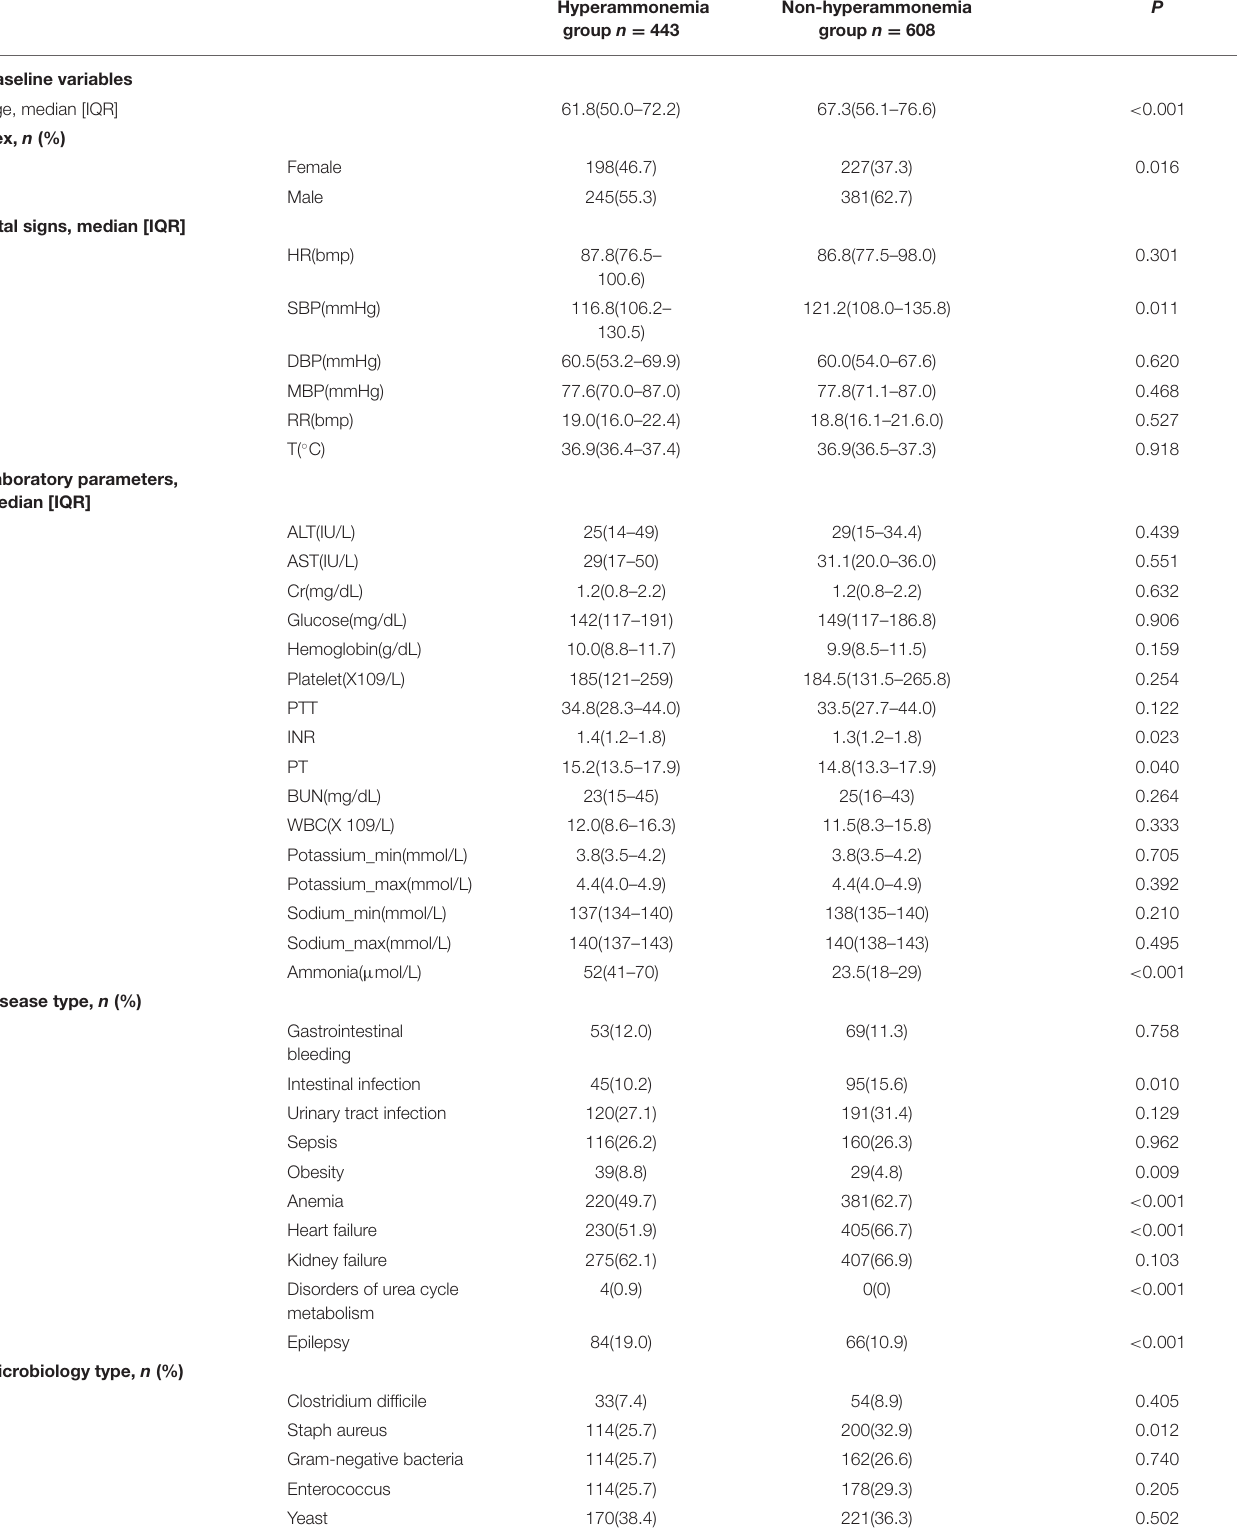
TABLE 1 | Baseline characteristics of the hyperammonemia and non-hyperammonemia